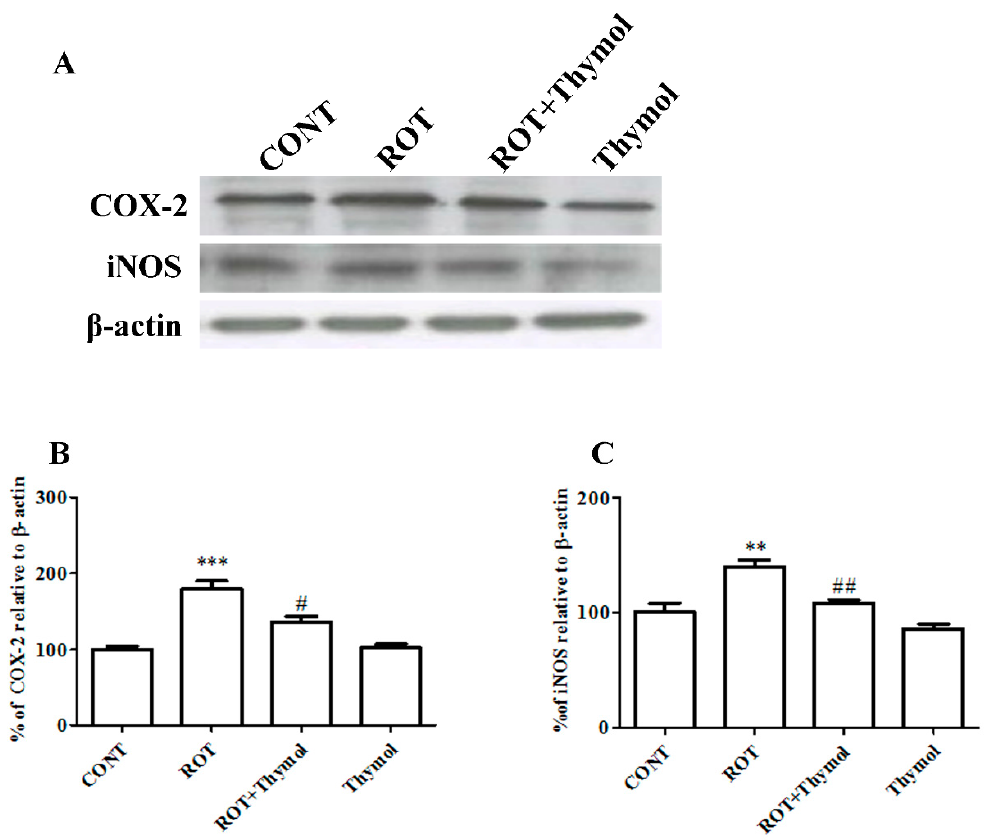
Figure 6. Striatal tissues were used to determine the expression levels of COX-2 and iNOS using western blotting ( A ). ROT challenge causes significant (*** p < 0.001) increase in COX-2 and iNOS levels when compared to CONT rats. Thymol treatment to ROT challenged rats exhibited significant (# p < 0.05; ## p < 0.01) decrease in the expression levels ofCOX-2 and iNOS as compared to rats received only ROT ( B , C ). Thymol alone treatment did not exhibit noteworthy change in the expression of COX-2 and iNOS when compared to vehicle injected rats of CONT group ( n = 4).